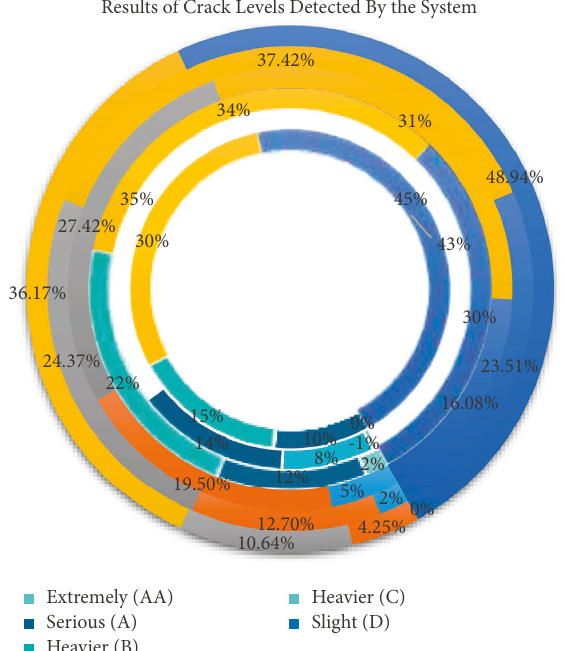
Figure 5: Results of crack levels detected by the system.